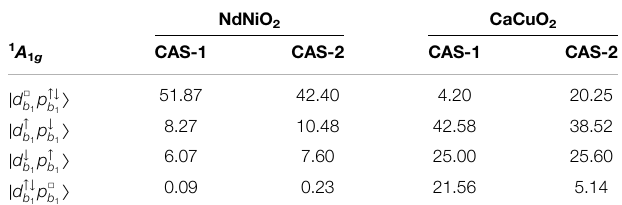
and p b are the 1 1